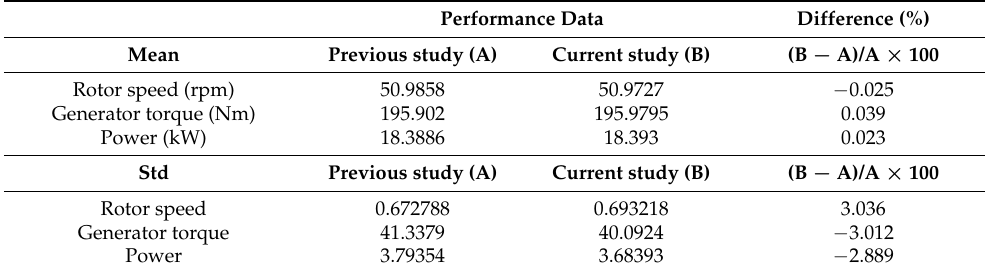
Figure 14. Dynamic simulation results of proposed stall control (current study) and stall control in a prior study (previous study): ( a ) average wind speed of 10 m/s (mostly Regions II and II-1/2); ( b ) average wind speed of 16 m/s (mostly Region III). Table 6. Quantitative comparison of controller performance at an average wind speed of 10 m/s with a turbulence intensity of 21% (mostly Regions II and II-1/2).